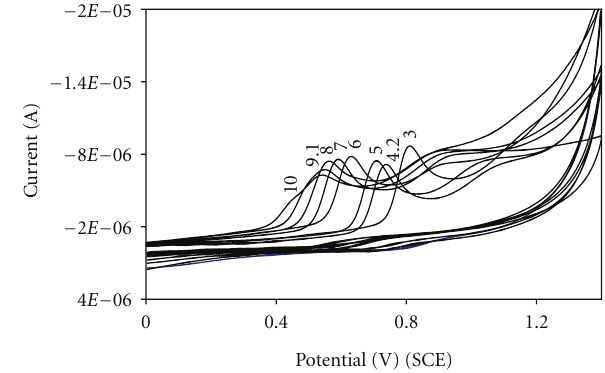
Figure 3: Cyclic voltammograms of 1.25 × 10 − 4 MMMF in